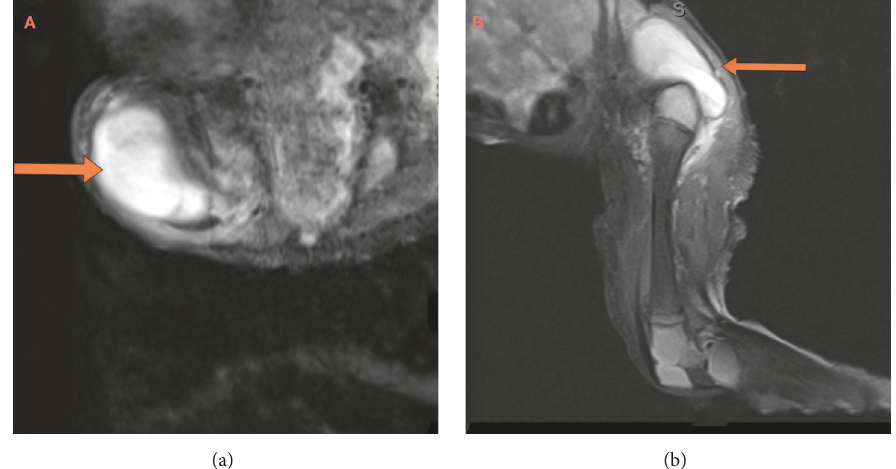
Figure 2: (a) MRI image axial cut demonstrating large subcutaneous fluid collection (arrow) in the thigh and (b) MRI image sagittal cut of the same patient’s right hip showing same fluid collection with corresponding joint effusion (arrow) concerning for septic